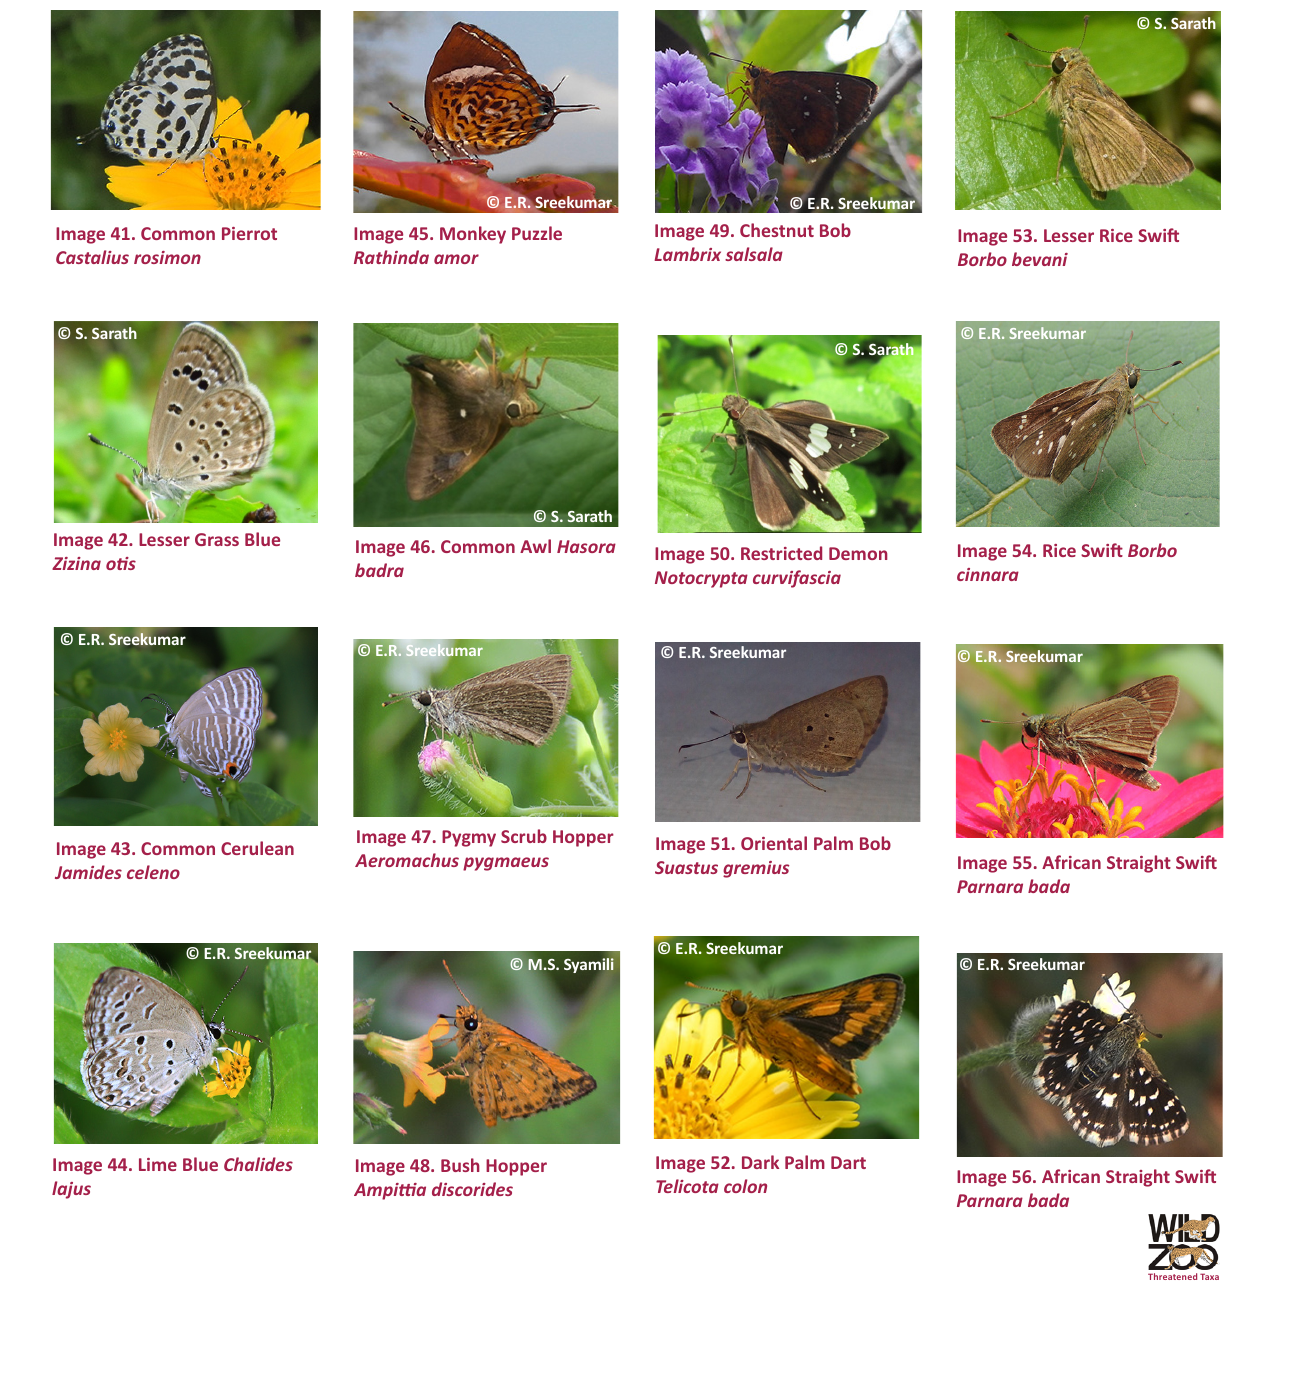
Image 41. Common Pierrot Castalius rosimon